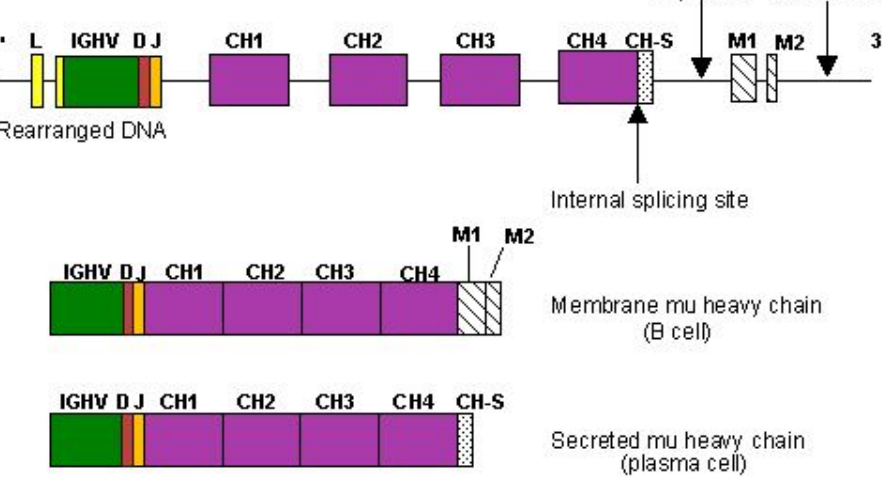
Figure 11. Synthesis of a membrane and of a secreted H-mu chain [2]. (With permission from M-P. Lefranc and G. Lefranc, LIGM, Founders and Authors of IMGT ® , the international ImMunoGeneTics information system ® , http: //